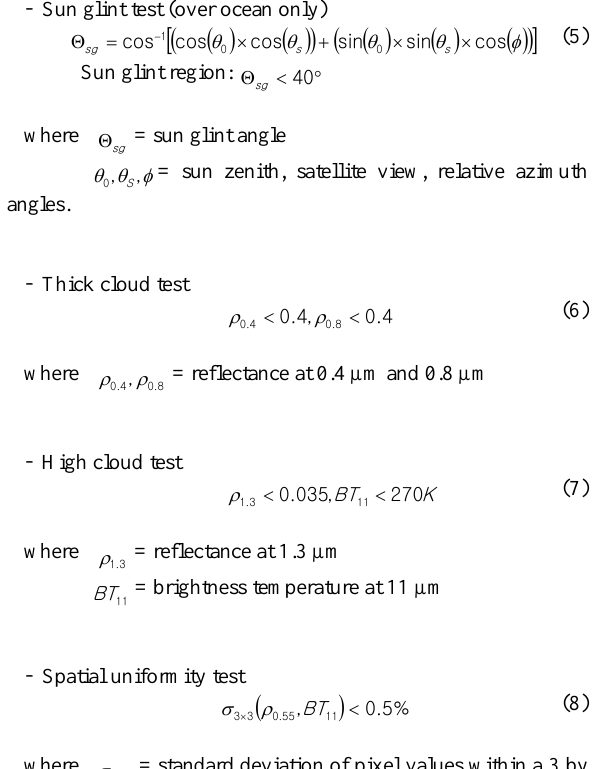
In the next step, cloud mask pixels (if possible, AMI cloud product, snow/ice mask from the AMI level-2 product will be used) including sun glint mask and day/night flag are determined. It should be noted that the cloud screening tests distinguishes cloud and low-aerosol-laden pixels from those with moderate to heavy aerosol conditions. Using observed spectral visible reflectances and infrared BT, the algorithm search for spectral signatures from clouds. The following tests are used to clear sky/cloud